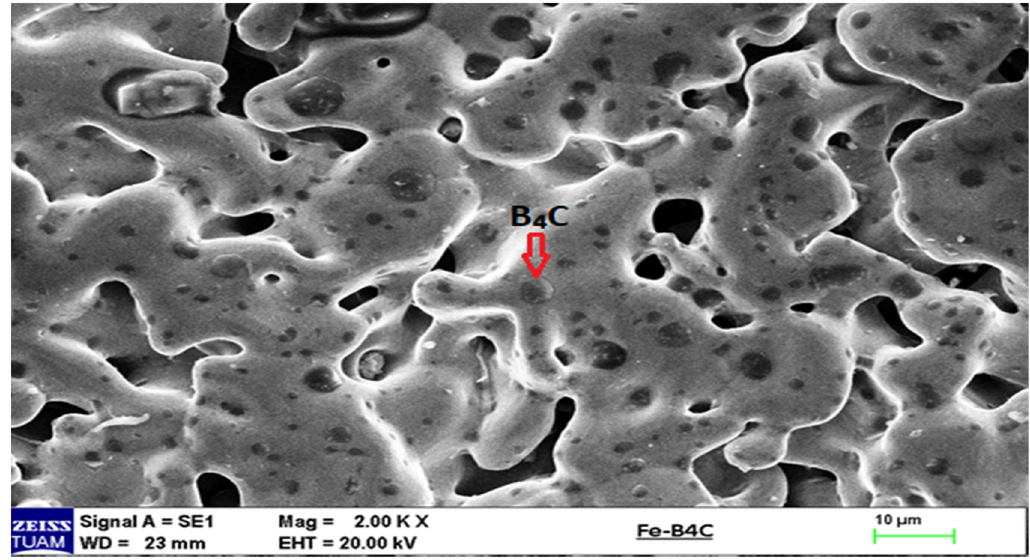
Figure 3: SEM picture of Fe – B 4 C